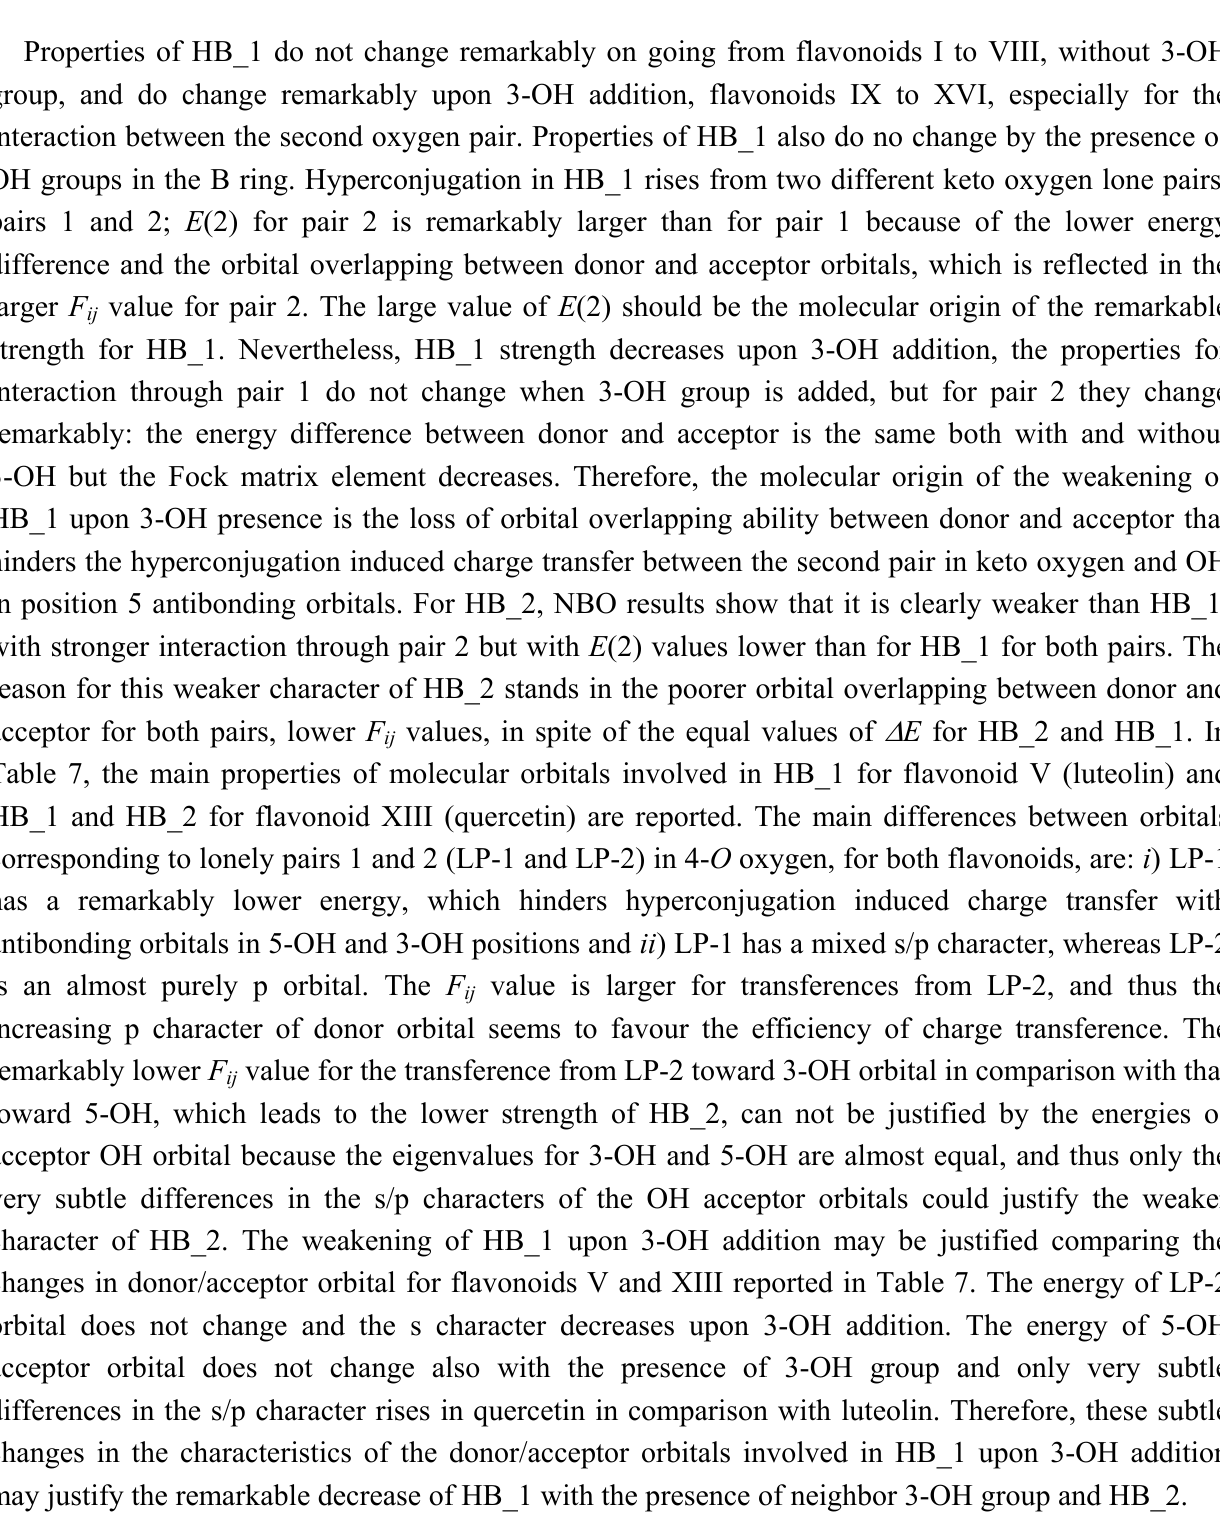
HB_1 and HB_2 for flavonoid XIII (quercetin) are reported. The main differences between